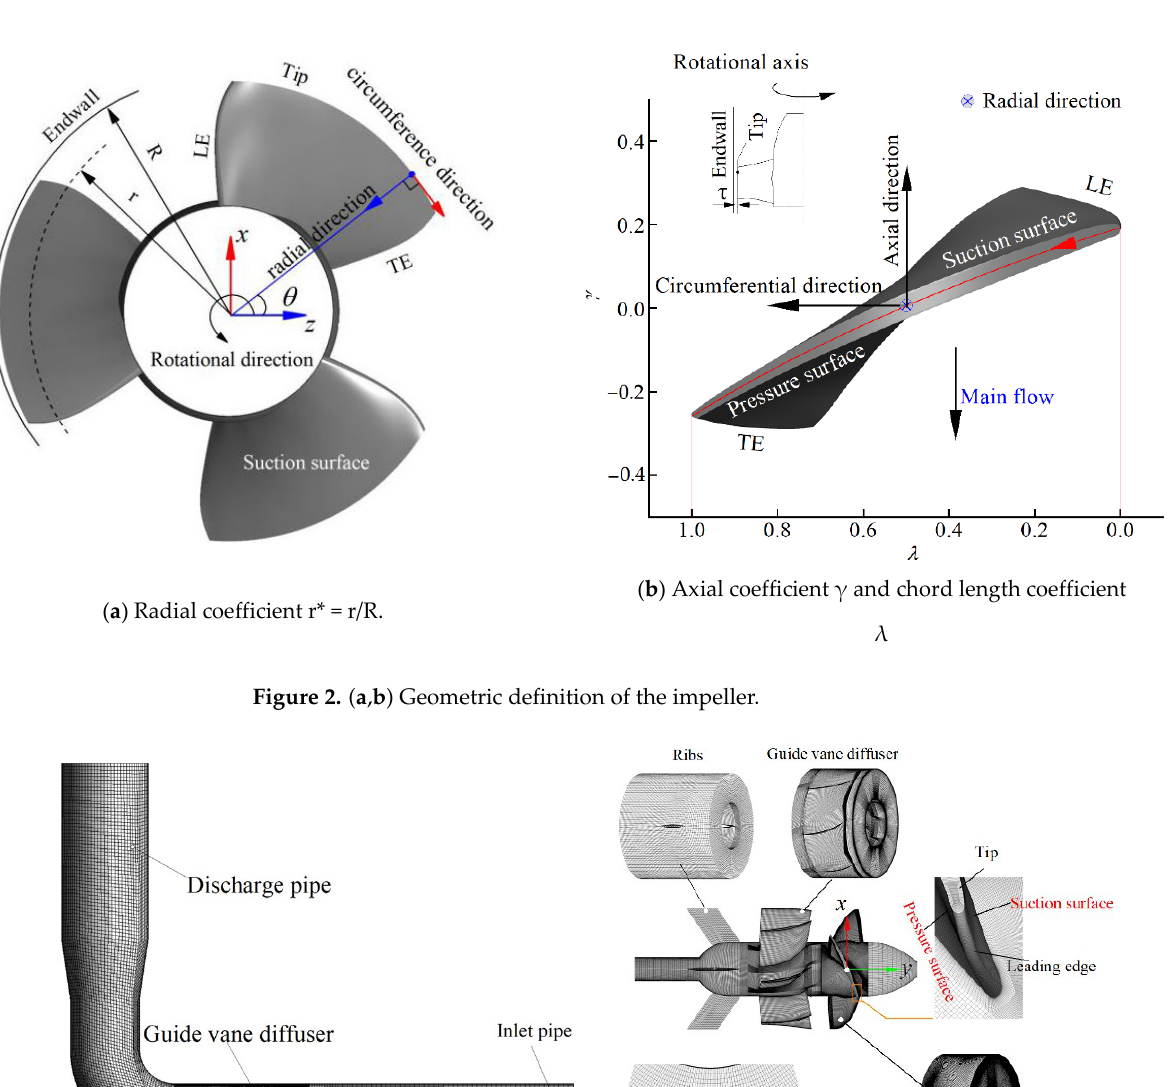
Figure 3. Computational grid of main components.